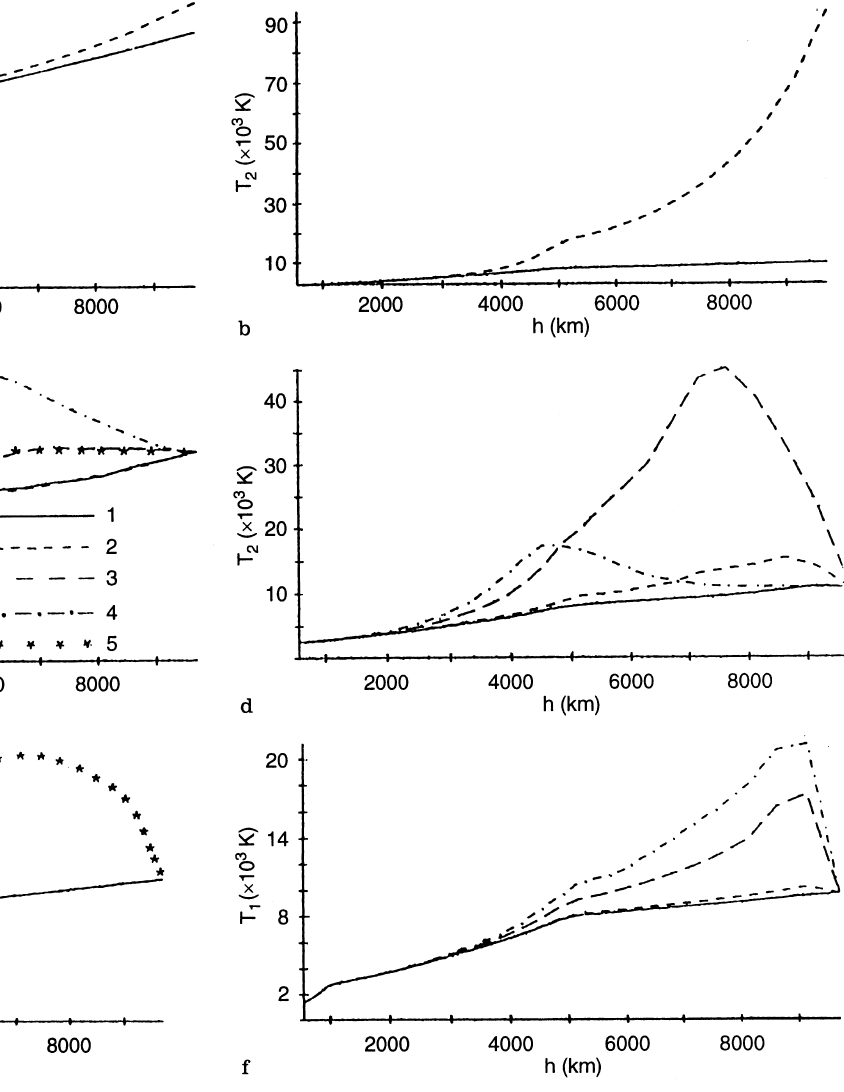
parallel electric current amounts to a j 2 (cid:136) 10 (cid:255) 6 A/m 2 , b j 2 (cid:136) 10 (cid:255) 5 A/m 2 . Background electron temperature T (cid:3) , solid curve , 2 electron temperature in turbulent region T 2 , dashed curve . In c–f only the temperatures in the turbulent region are shown, j 2 (cid:136) 10 (cid:255) 6 A/m 2 , and C equals (cid:133) 1 (cid:134) 1 : 5 s (cid:255) 1 , (cid:133) 2 (cid:134) 1 : 5 (cid:1) 10 (cid:255) 1 s (cid:255) 1 , (cid:133) 3 (cid:134) 1 : 5 (cid:1) 10 (cid:255) 2 s (cid:255) 1 , (cid:133) 4 (cid:134) 1 : 5 (cid:1) 10 (cid:255) 3 s (cid:255) 1 , (cid:133) 5 (cid:134) 1 : 5 (cid:1) 10 (cid:255) 4 s (cid:255)